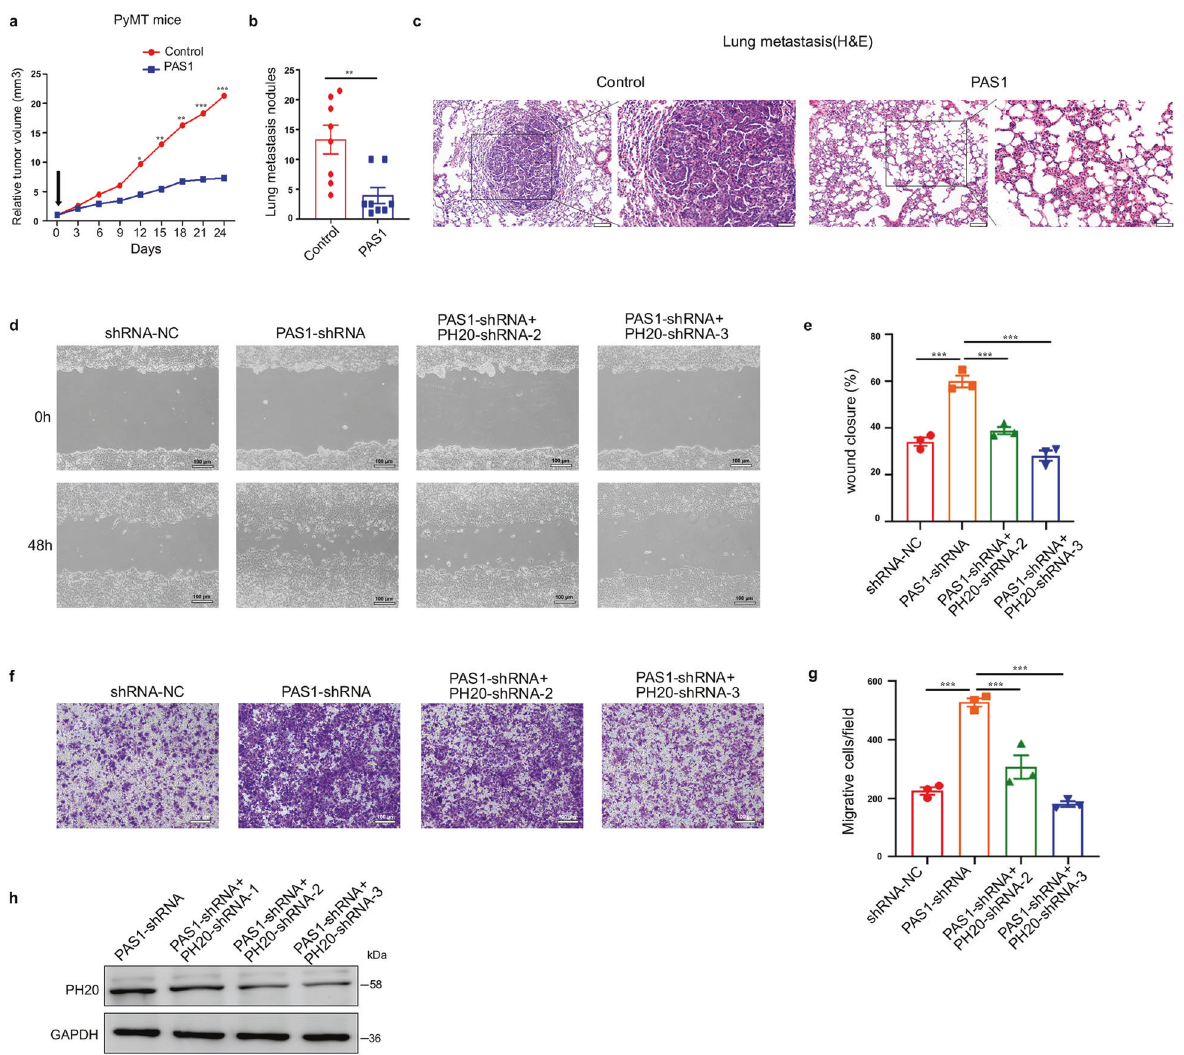
Fig. 5 PAS1 inhibits cancer cell growth and metastasis. a Control or PAS1-expressing lentiviruses were orthotopically injected into multiple mammary glands of PyMT mice. Tumor-growth curves were derived by measuring tumor volume once every 3 days Data are mean of tumor volume (control group, n = 45 tumors; PAS1 group, n = 46 tumors). b Lung-metastatic nodules were counted ( n = 8/group). Data are means ± SEM by two-tailed t test. c Representative lung-metastasis specimens were sectioned and stained with H&E. d – g PH20 shRNAs were transfected into stable MCF-7-control/PAS1-shRNA cells. Wound healing scratch and migration assays were performed in the stable cells. Data are from three experiments by two-tailed t test. h The ef fi cacy of PH20 shRNAs was detected by Western